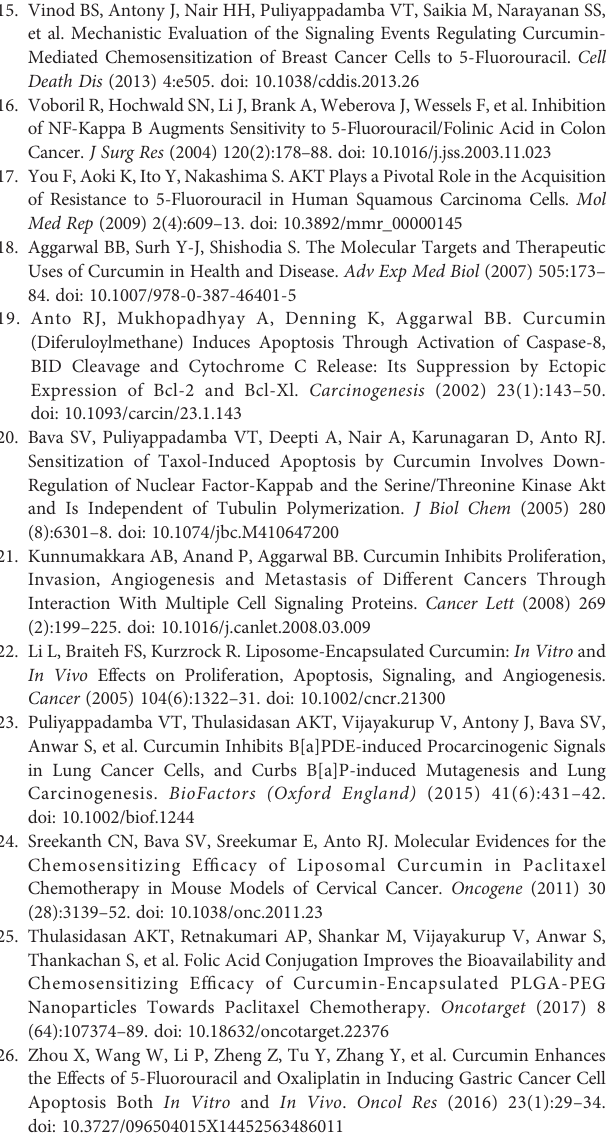
Supplementary Figure 1 | (A, B) Graphs showing the percentage of apoptotic cells in different treatment groups upon H&E staining and TUNEL staining of the